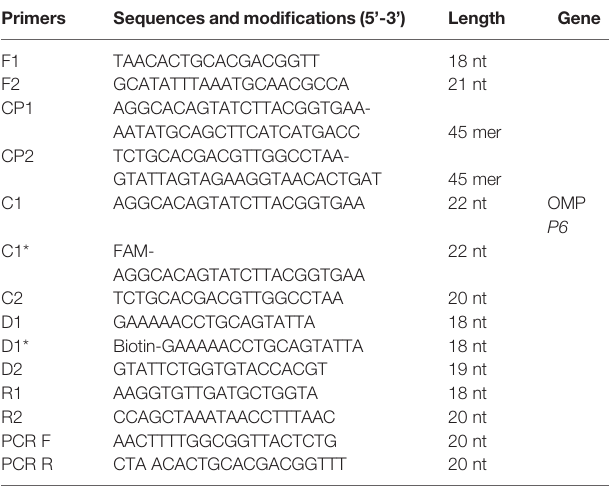
TABLE 2 | The primers used in this study.